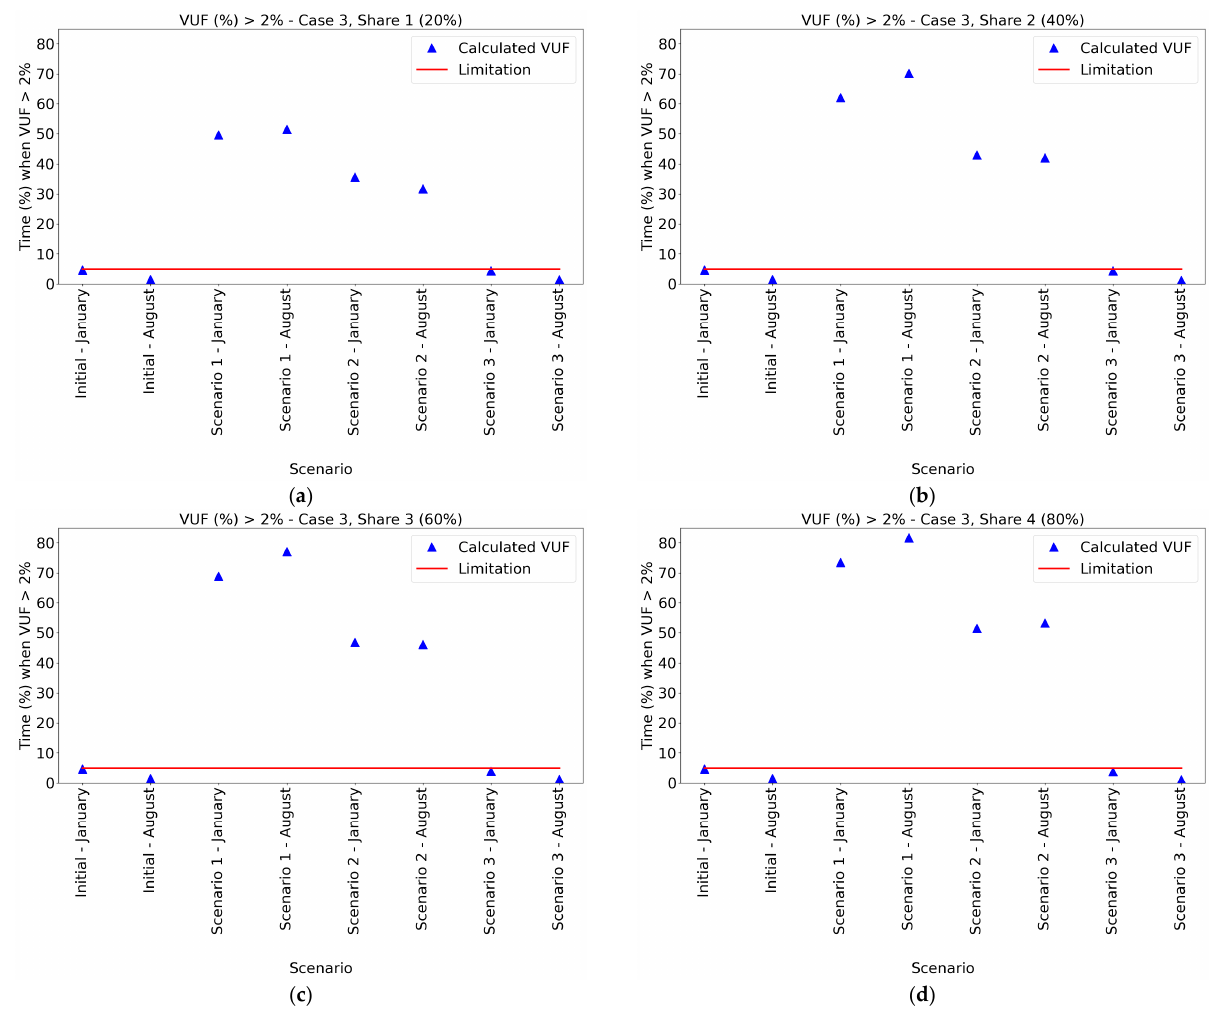
Figure 7. VUF > 2%—Case 3; Share 1–Share 4; January,